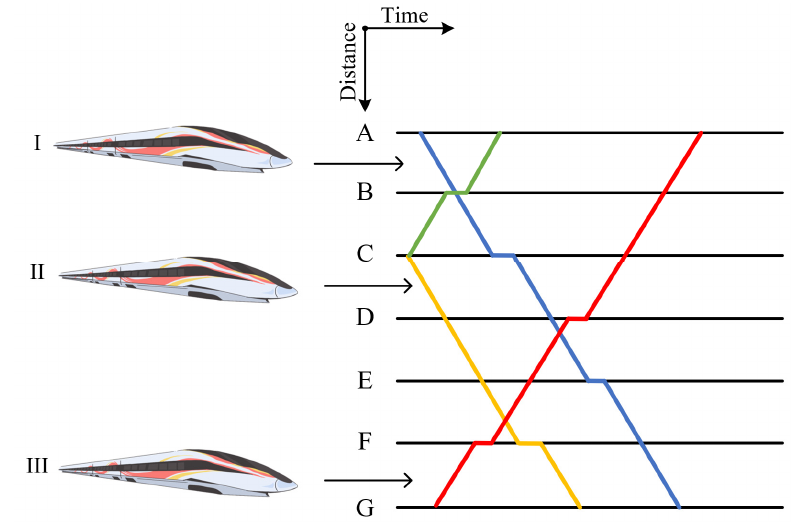
Figure 5. The train-set directions in each station.